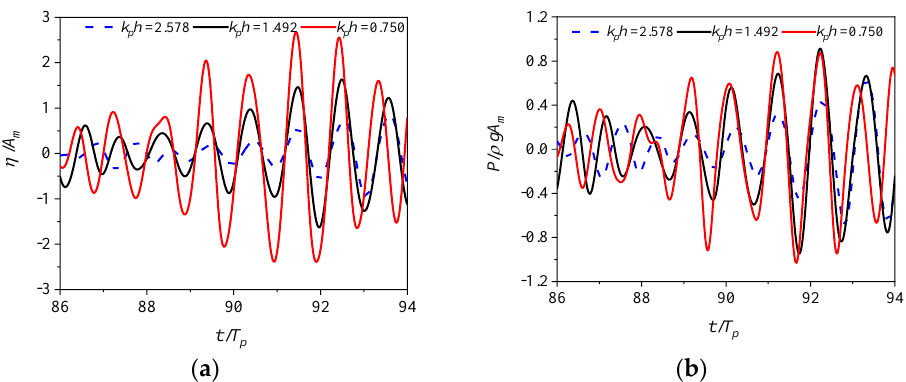
Figure 7. Comparison of the ( a ) surface elevation at the chamber center and ( b ) pneumatic pressure in the chamber for three different values of k p h in the OWC chamber.